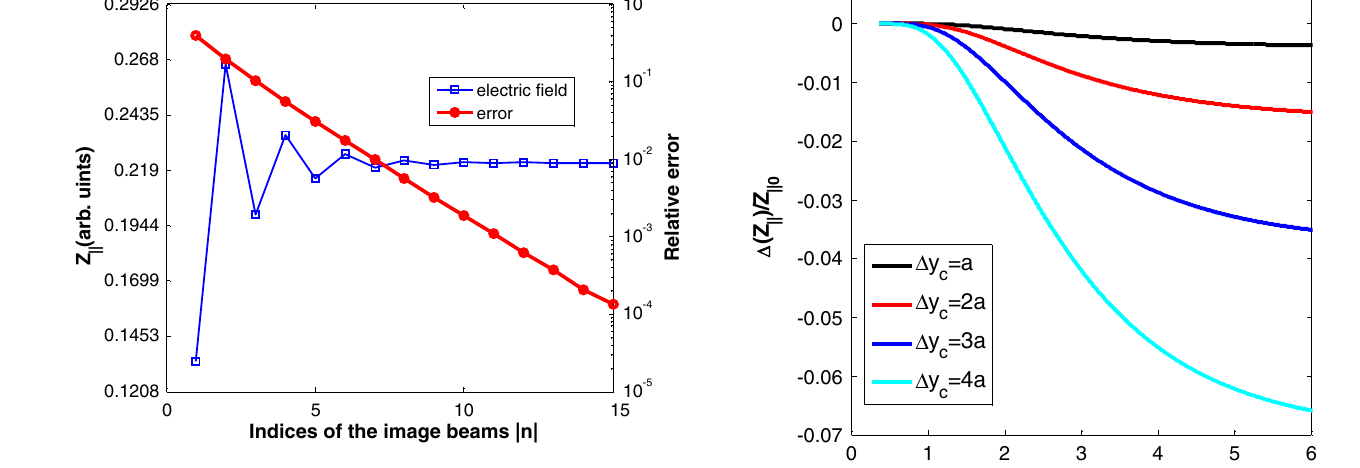
FIG. 5. Convergence of the on-axis LSC impedance with the maximum index of image beams for a parallel-plate chamber. The bunch has a radius of a ¼ 5 mm and the full separation of the parallel plate is h ¼ 4 a ¼ 20 mm. This result corresponds to the case γ = ð ka Þ ¼ 8 as shown in Fig. 4 where the image charge effect is relatively larger.